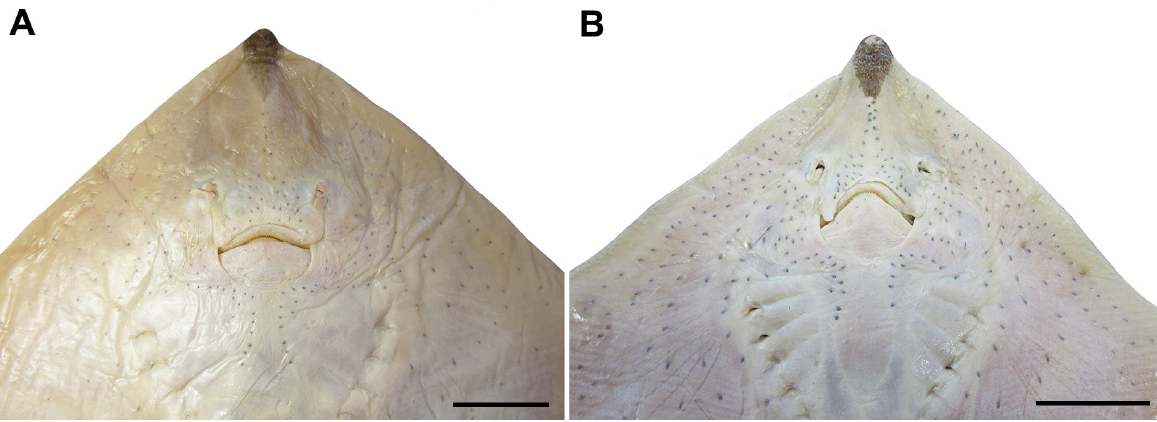
FIGURE 4 | Ventral view of the head of Rioraja agassizii . A. MZUSP 117280, female, 543 mm TL. B. USP (uncatalogued), male. Scale bars = 20